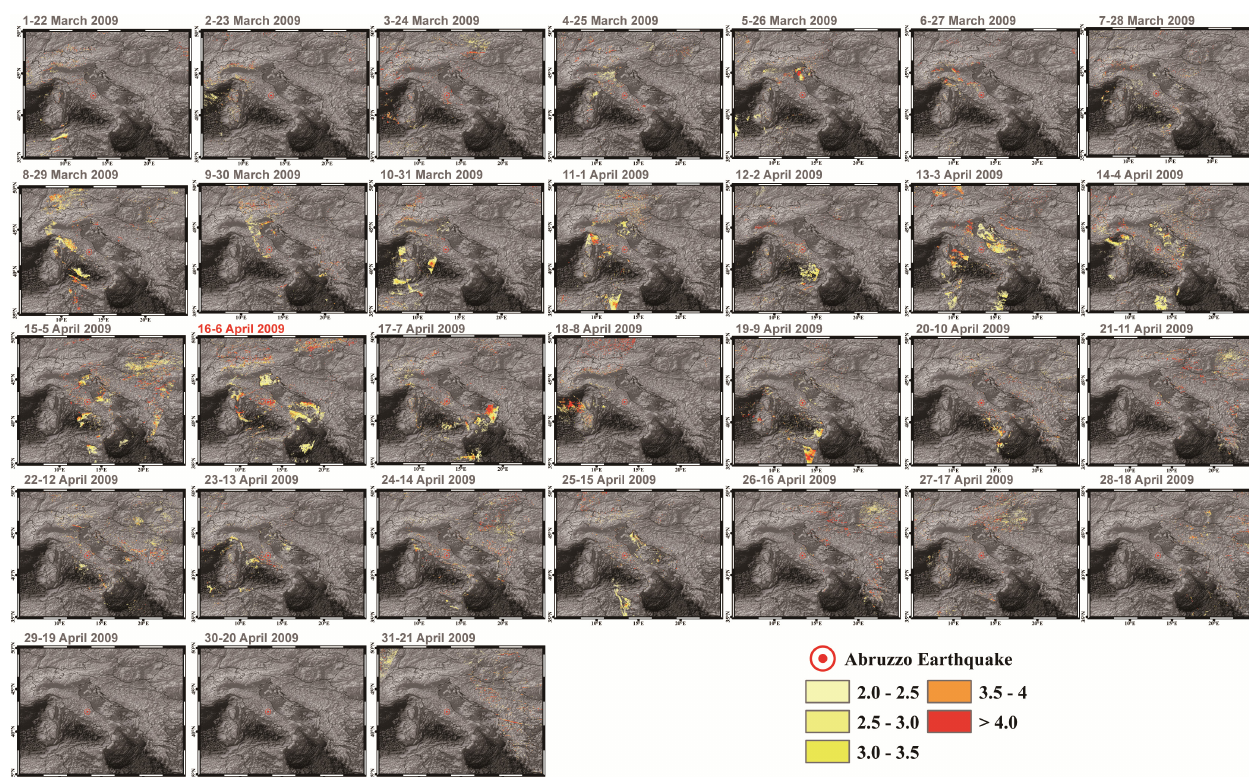
Figure 6 Results of the RETIRA index computation on the investigated area before and after the Abruzzo earthquake using AATSR BT data (forward view) from 22 March 2009 to 21 April 2009.